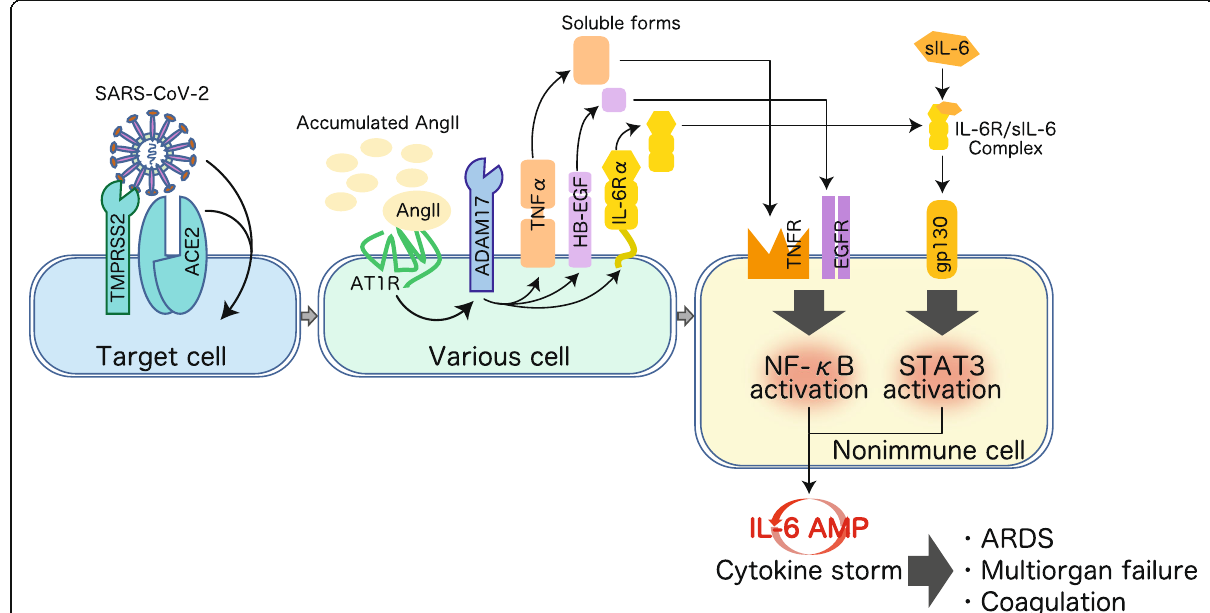
Fig. 1 IL-6-STAT3 signaling is a potential therapeutic target for COVID-19 mediated by cytokine storm. SARS-CoV-2 enters cells via cell membrane- localized ACE2 depending on TMPRSS2 and CatB/L activities for viral S protein priming. The viral pathogen-associated molecular patterns trigger IL-6 production followed by activation of the NF- κ B pathway via PRRs in both immune and non-immune cells, leading to an inflammatory response. On the other hand, upon the occupancy of ACE2 by SARS-CoV-2, the increased serum level of free Ang II due to a reduction of ACE2- mediated degradation also promotes activation of the NF- κ B pathway via AT1R, followed by IL-6 production. Simultaneously, Ang II-AT1R signaling activates ADAM17 and ADAM10 protease activity, and the resulting production of TNF- α , sIL-6R α , and EGF initiates the TNFR-NF- κ B,